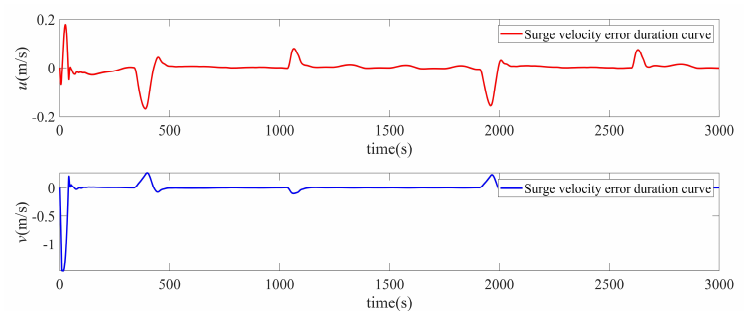
Figure 9. Error duration curve of estimated velocity and actual velocity.